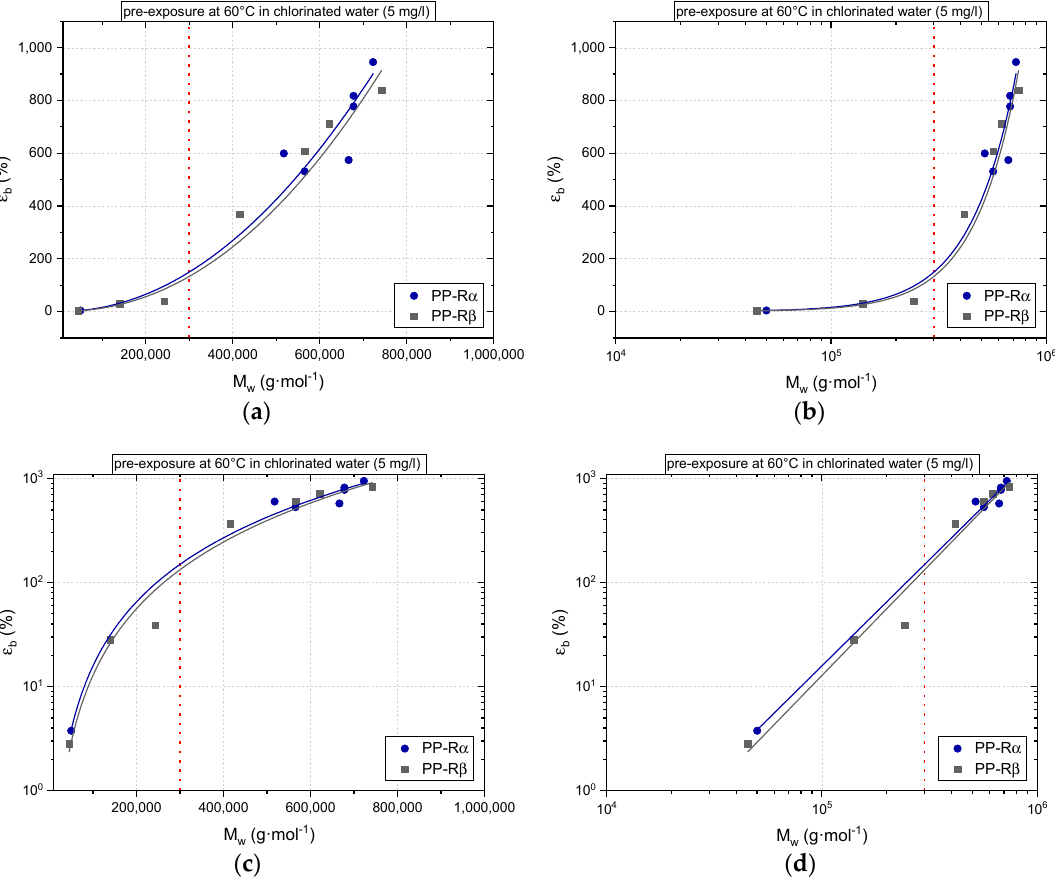
Figure 10. Dependence of strain at break values ( ε b ) of aged PP-R α and PP-R β on the mean molar mass ( M w ) of the materials in the aged state comparing diagrams of various scales; ( a ) linear ε b vs. linear M w , ( b ) linear ε b vs. log M w , ( c ) log ε b vs. linear M w , and ( d ) log ε b vs. log M w .